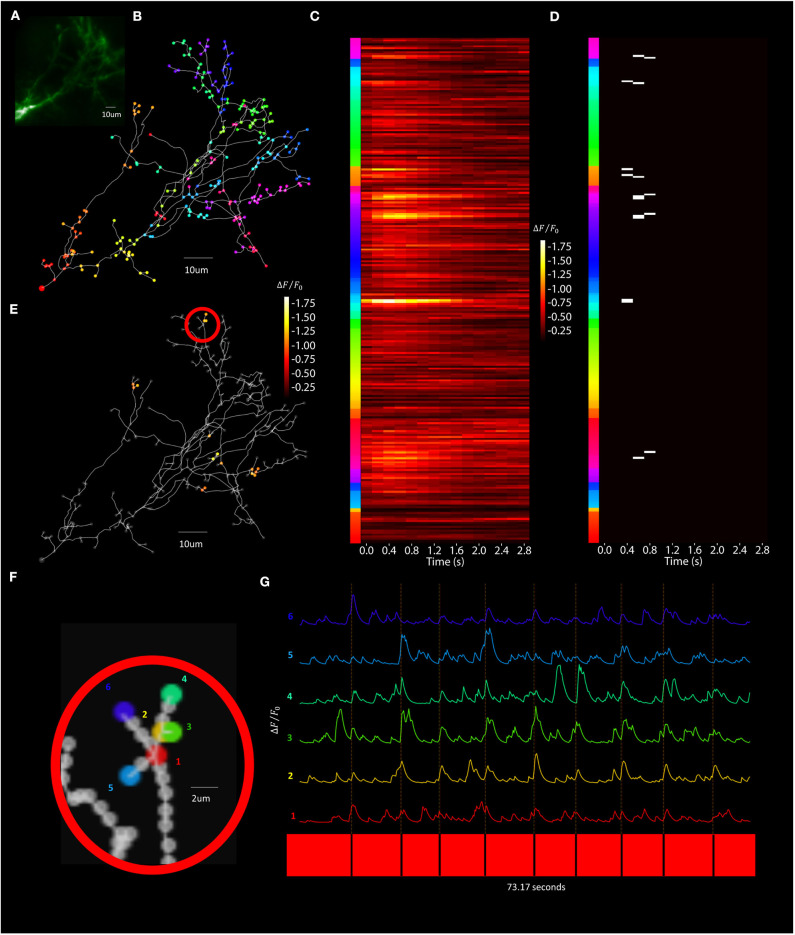
Visually evoked synaptic-localized glutamate transients across the neuron can be detected using Segmented Scanning. (A) A standard deviation projection image in the green channel of a Xenopus tectal neuron expressing shown sfGFP-iGluSnFR-A184S. (B) Locations of a total of 259 POIs sampled across the soma, dendritic branch points, filopodia bases and tips. (C) Stimulus-evoked iGluSnFr ΔF/F0 response for 3 s post-stimulus at each POI, collected at a rate of 6 Hz and averaged over 9 50 ms “OFF” stimuli. (D) Transient events detected using a matched filter algorithm (Sakaki et al., 2018), identifying evoked increases that match Super-folder-GFP-iGluSnFR-A184S dynamics (τR¯ = 5 ms, τF¯ = 150 ms) and a window size of 8. (E) Locations and strengths of the responses located spatially across the arbor. (F) A series of POIs recorded corresponding to filopodia tips and bases and (G) the individual iGluSnFr traces of those POIs.